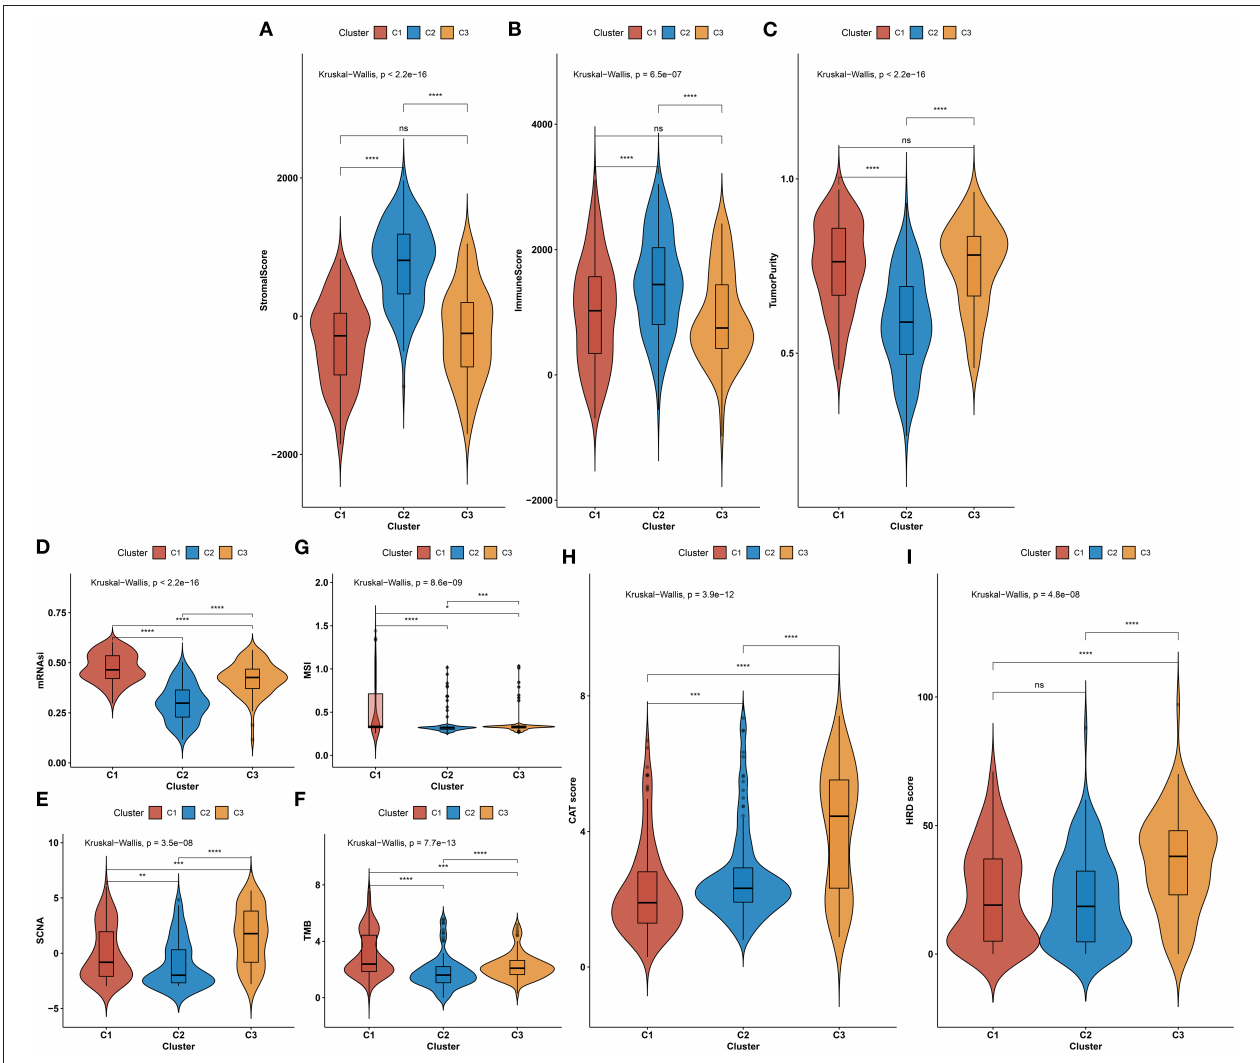
FIGURE 5 | Aging-associated molecular phenotypes associated with immunotherapeutic response predictors in gastric cancer. (A–C) Distributions of stromal and immune scores as well as tumor purity among three aging-associated molecular phenotypes. (D–G) Comparisons of mRNAsi, SCNA, MSI, and TMB scores among three aging-associated molecular phenotypes. (H,I) Comparisons of CAT and HRD scores in diverse aging-associated molecular phenotypes. * p < 0.05; ** p < 0.01; *** p < 0.001; **** p < 0.0001; ns, not